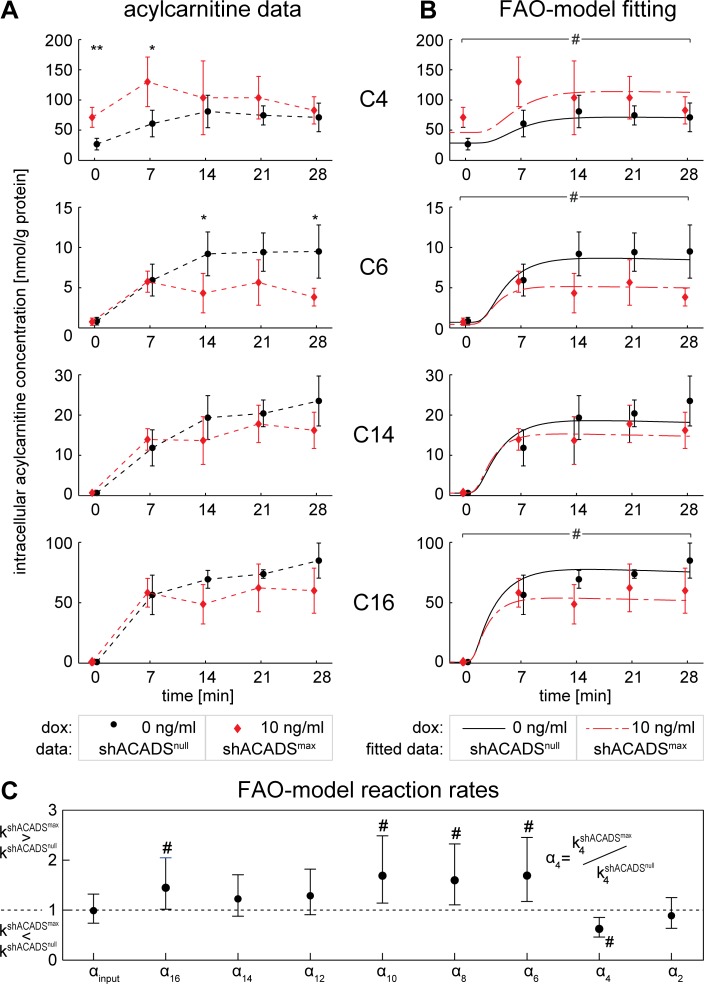
Time-course of intracellular acylcarnitine levels in ACADS knockdown cells—comparison of distinct time-points and kinetic differences.(A) Intracellular acylcarnitine levels, representing acyl-CoAs with corresponding chain length, were extracted and measured before palmitic acid loading and 7, 14, 21 and 28 min after loading in shACADS knockdown Huh7 cells, i.e. shACADSnull and shACADSmax cells treated with 0 and 10 ng/ml doxycycline (dox), respectively, for shRNA induction. Shown are levels of C4-acylcarnitine as primary outcome, C14-, C6-acylcarnitines representing long- and medium-chain acylcarnitines, and C16-acylcarnitine (note that data for acylcarnitines C2 to C16, including the here presented, are given in S2 Fig). Values of four independent experiments are shown as mean ± SD (original data of single measurements are given in S1A Table). Time point specific comparison between shACADSnull and shACADSmax, were performed using t-tests; *p < 0.05 and **p < 0.01. Results for all acylcarnitines in S2 and S3 Figs for cells treated with shACADS and shNTC, respectively. (B) Results from fitting of linear FAO model to the measured data (note that data for acylcarnitines C2 to C16 are given in S2 Fig). (C) FAO model based quantification of differences in acylcarnitine flux. shACADSnull and shACADSmax are compared by the ratio α = kshACADSmax / kshACADSnull, reaction rates k are derived from the FAO model fits. α-values from best model fits are represented as dots with respective 95% confidence intervals. (B+C) # indicates significant difference (p < 0.05) between reaction rate kshACADSmax and kshACADSnull of the respective knockdown experiments. For details of dynamical modelling, see materials and methods, S4–S6 Figs and S1 Text.